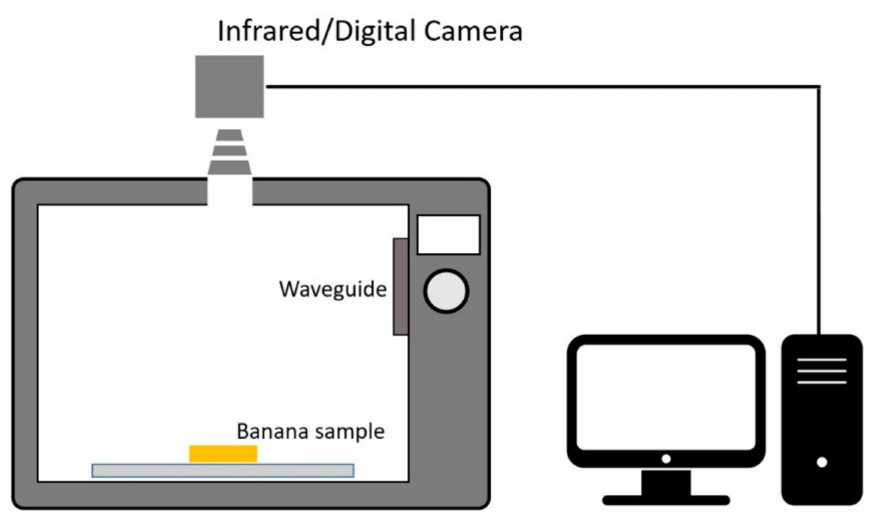
Figure 6. Schematic diagram of microwave heating